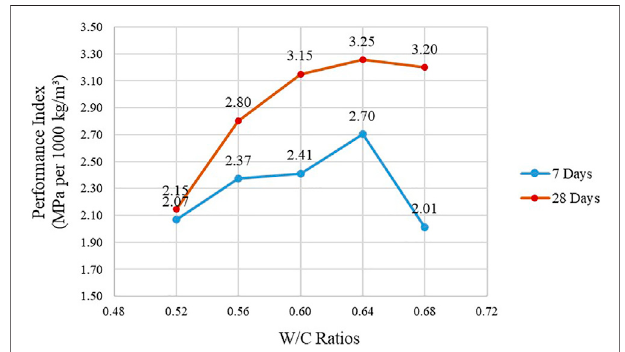
FIGURE 3 | Performance index of LFC-CTW0.